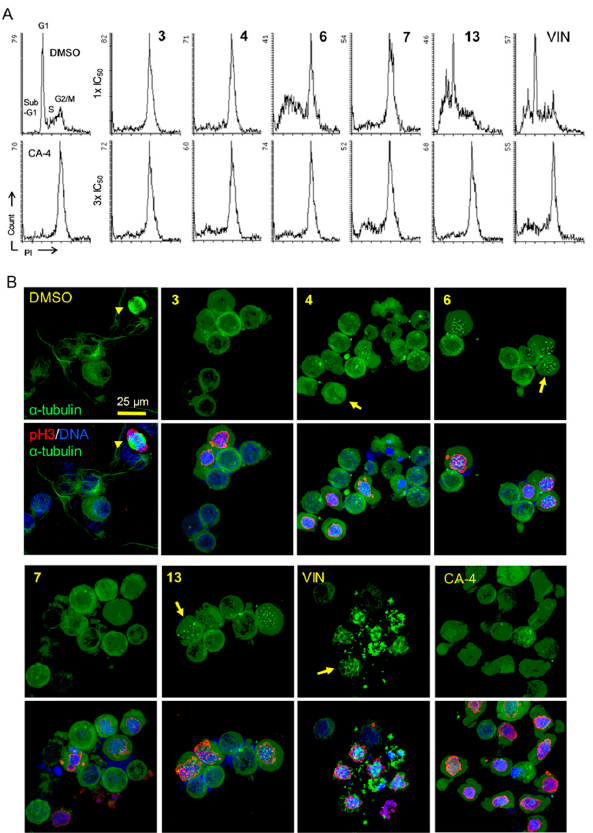
Figure 2. Mitotic defects in KB-VIN cells treated by compounds. ( A ) Vincristine-resistant subline KB-VIN cells were treated with compounds for 24 h at a concentration of one- or three-fold IC 50 (1 × IC 50 or 3 × IC 50 ). CA-4 at 0.2 µ M was used as a colchicine-type tubulin polymerization inhibitor. Cell cycle distributions (sub-G1, G1, S, G2/M) were analyzed using flow cytometry after staining cells with propidium iodide (PI). ( B ) KB-VIN cells were treated with compounds for 24 h at a concentration of 3 × IC 50 . CA-4 was used at 0.2 µ M. Fixed cells were stained with antibodies to α -tubulin (green) and phospho-histone H3 (pH3, red), and DAPI was used for DNA (blue). Stained cells were observed by confocal fluorescence microscope. The represented image is a projection of 15~20 optical sections acquired at 0.5~1 µ m intervals. Normal mitotic spindle formation (arrow head) in control (DMSO) and dotted tubulin aggregations without spindles ( 4 , 6 , 13 ) or with multipolar spindles (VIN) were observed (arrows). Bar, 0.025 mm. Additional images are available in Supplementary Figure S1.